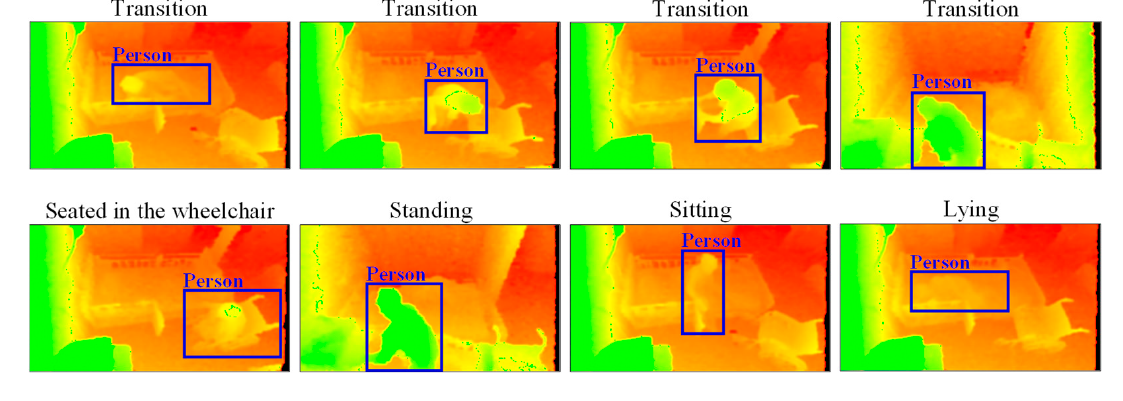
Figure 8. Specific action images.